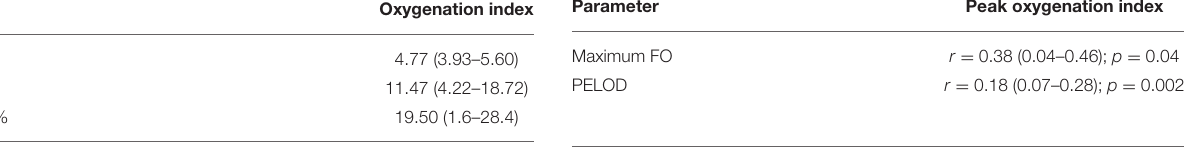
TABLE 5 | Mortality statistics of PICU